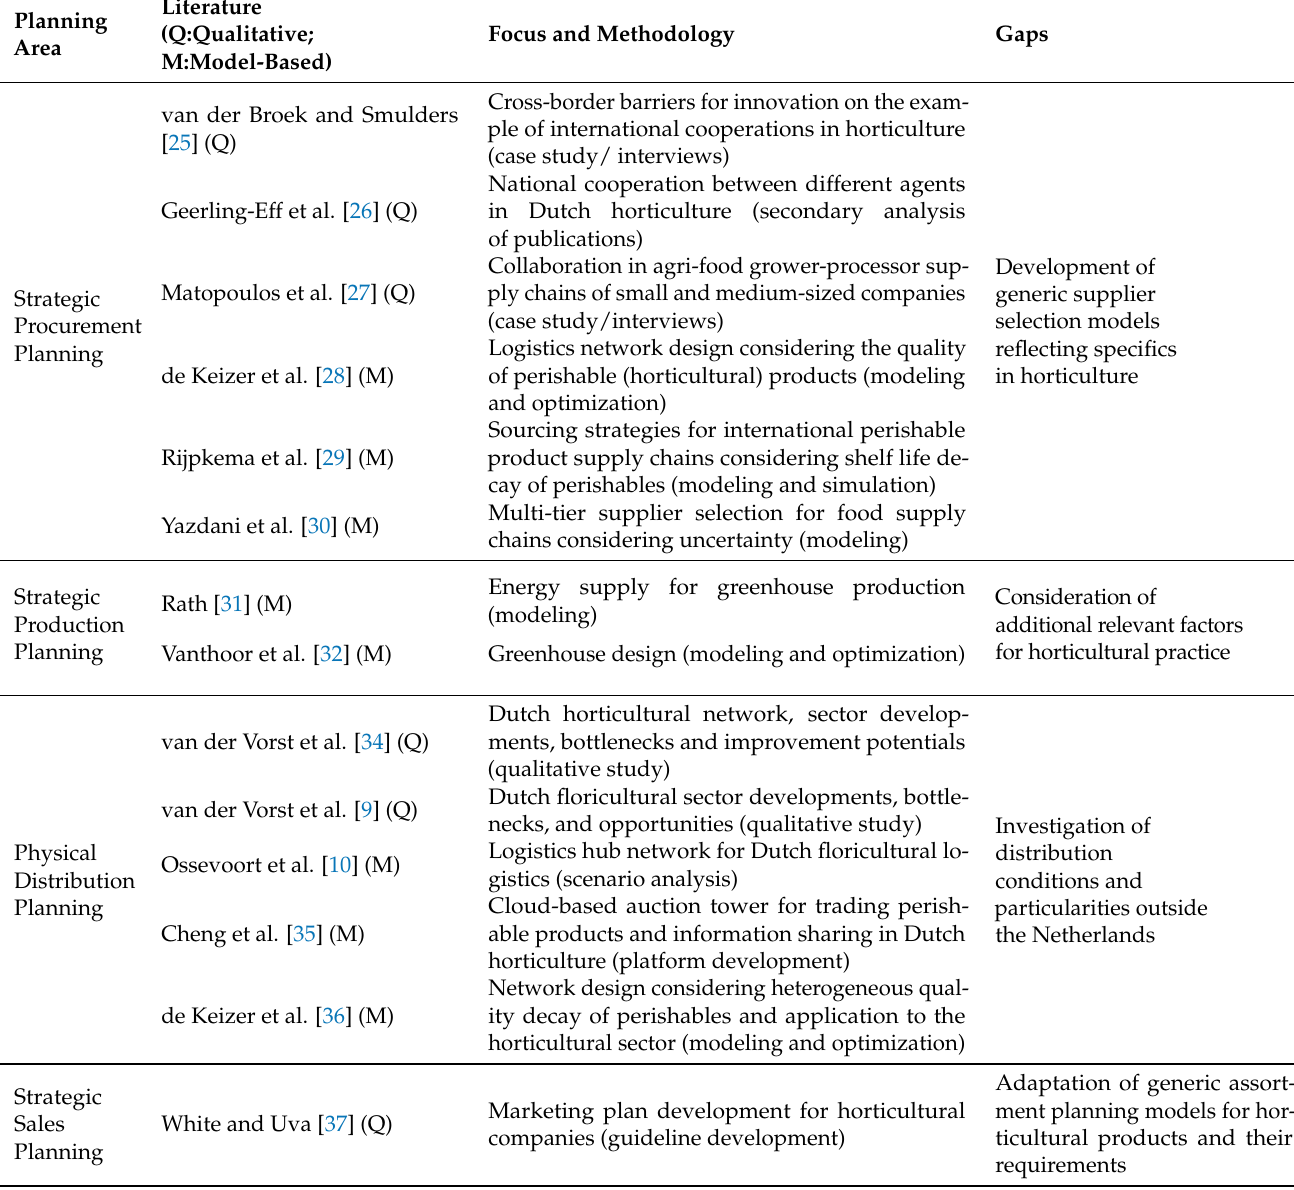
Table 2. Literature on strategic supply chain planning in horticulture or aligned